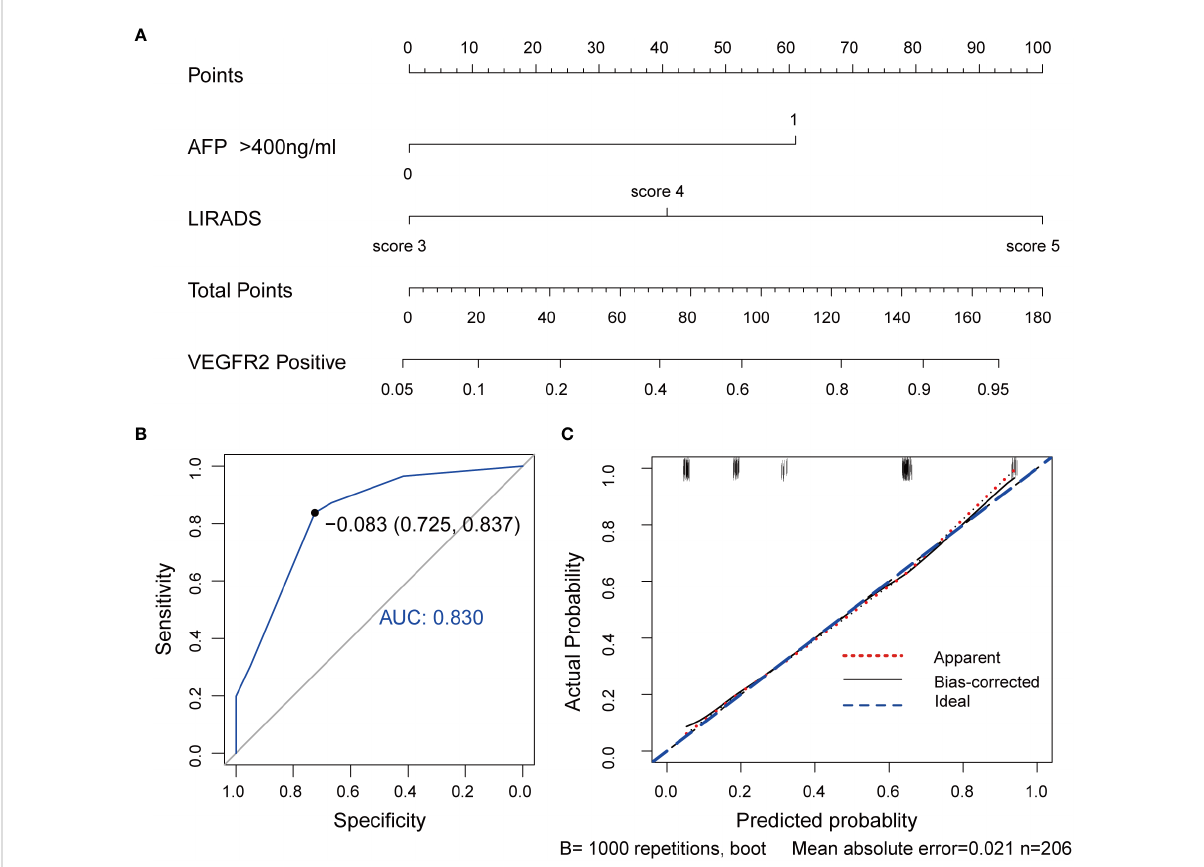
FIGURE 4 VEGFR2-positive-risk nomogram establishment and validation. (A) Risk nomogram incorporating AFP and the LI-RADS score for predicting high VEGFR2 expression in HCC patients. (B) ROC curve for the nomogram ’ s VEGFR2-positive prediction AUC, sensitivity, and speci fi city. (C) Calibration curves illustrating the nomogram ’ s calibration in terms of the agreement between the predicted risk of high VEGFR2 expression and the actual pathological VEGFR2 expression status. The 45 ˚ blue line represents a perfect prediction, the red dashed line shows the nomogram ’ s predictive performance, and the black solid line is bias-corrected. The nomogram ’ s forecast accuracy improves as the dashed line approaches the ideal line. AUC, area under the curve; AFP, alpha-fetoprotein, LI-RADS, Liver Imaging Reporting and Data System, VEGFR2, vascular endothelial growth factor receptor 2, ROC, receiver operating